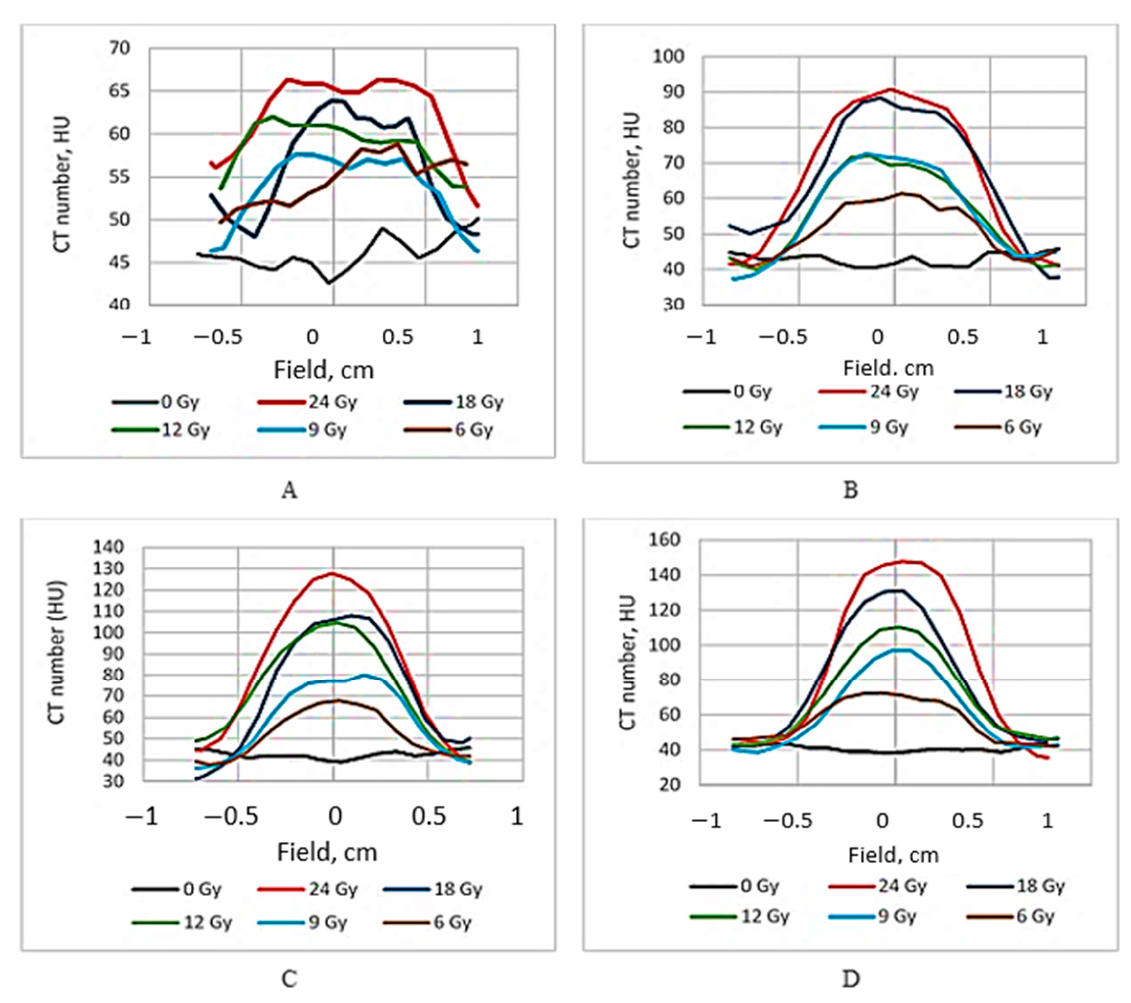
Figure 3. Dose profiles of irradiated nMAG gels CT evaluated at different post-irradiation times: ( A ) just after irradiation; ( B ) after 56 h; ( C ) after 240 h; and ( D ) after 2300 h .